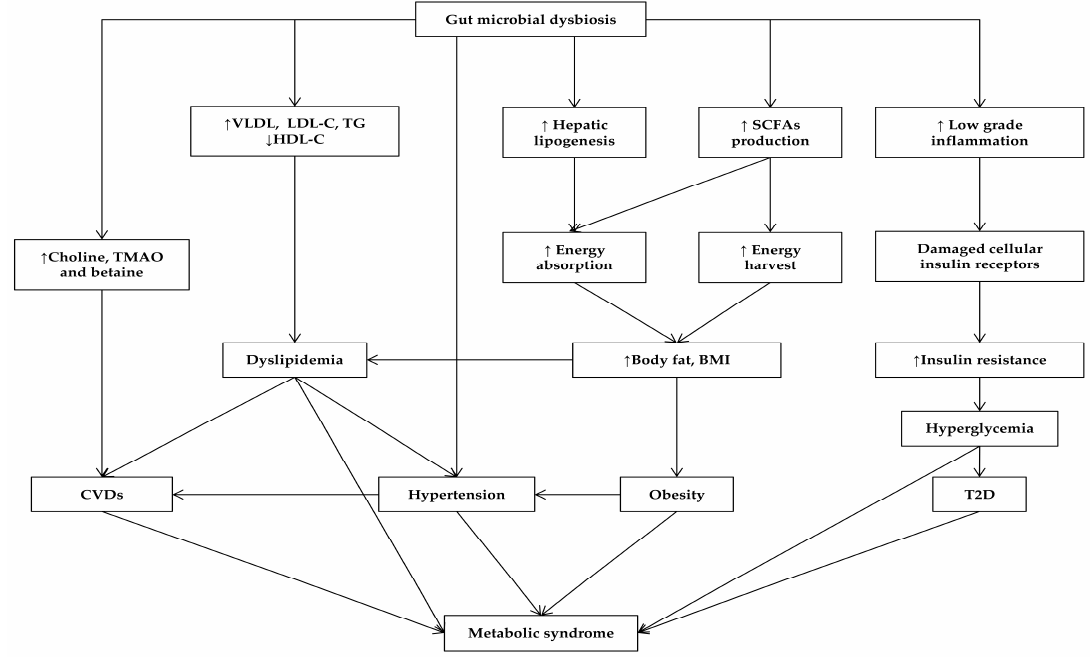
Figure 1. Gut microbiota affects MetS and its related diseases. Arrows indicate increase ( ↑ ) or decrease ( ↓ ). TMAO, trimethylamine N-oxide. TMAO, trimethylamine